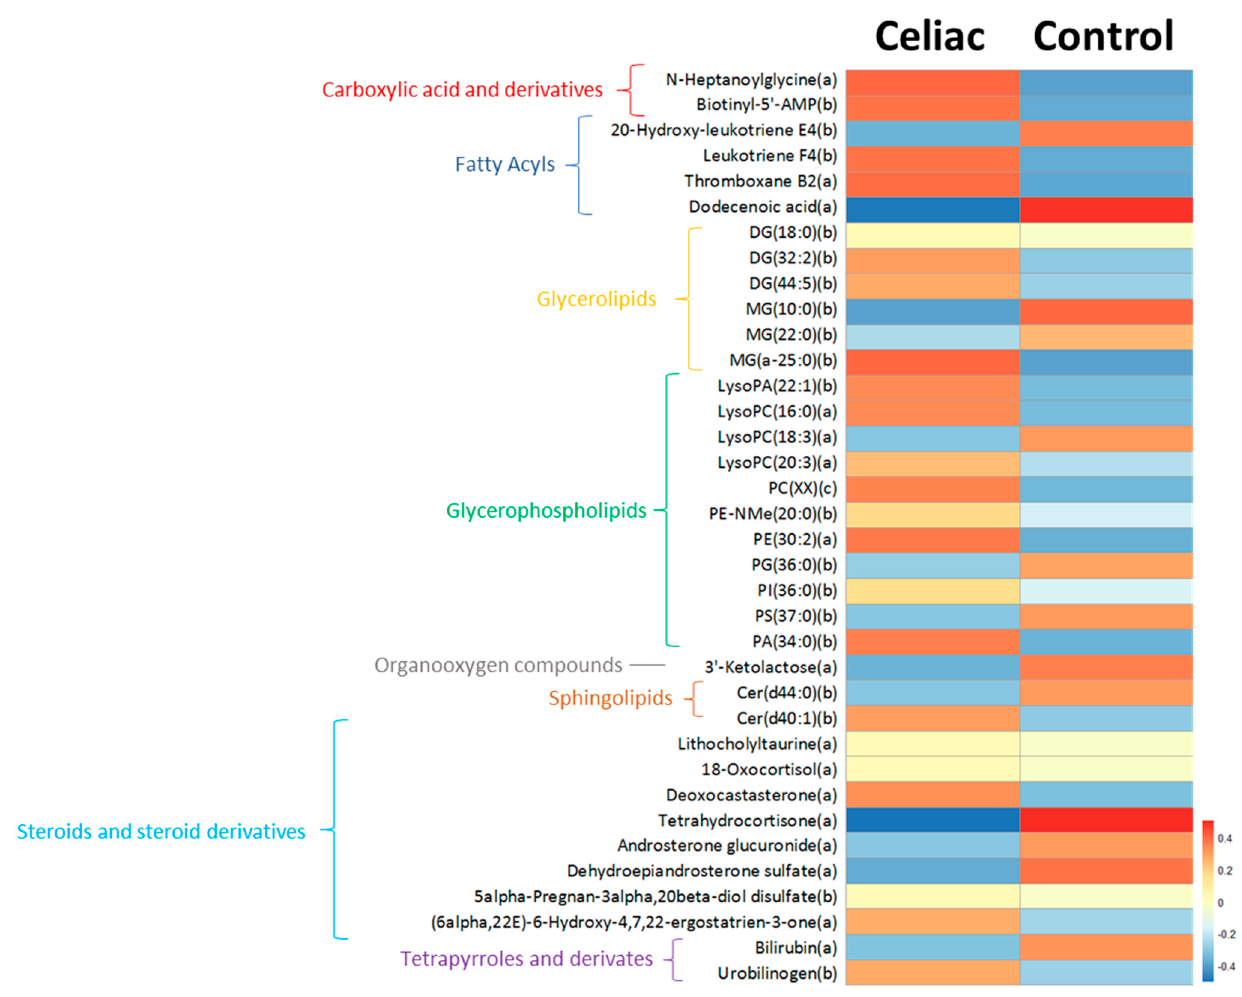
Figure 1. Putatively annotated plasma metabolites significantly different in CD subjects compared to healthy siblings. Levels of statistically significant molecules are represented using a heatmap. Each line of the heatmap represents a lipid species colored by its abundance intensity normalized with an internal standard, log-transformed, and auto-scaled. The scale from blue to red indicates the normalized abundances in arbitrary units. All compounds are putatively annotated based on physicochemical properties and/or spectral similarity with public/commercial spectral libraries [33]. (a) ID based on exact mass, RT, and MS/MS spectrum; (b) ID based on exact mass and RT; and (c) ID based on MS/MS spectrum. PC(XX): the specific phosphatidylcholine species could not be annotated, but its MS/MS spectrum displayed a PC- characteristic